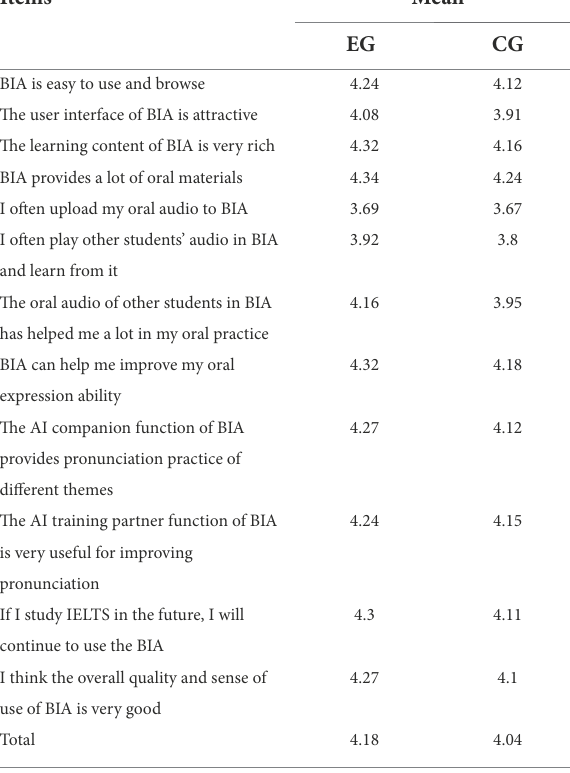
TABLE 1 The average score of the participants for the questionnaire about the Brother IELTS App.